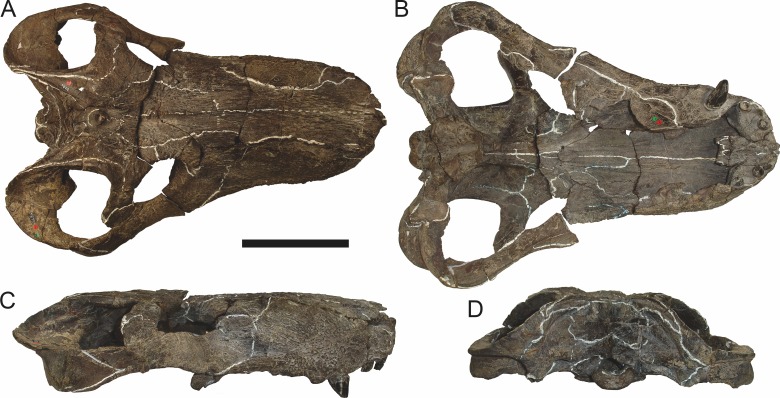
Referred specimen (UMZC T878) of Sycosaurus nowaki (Broili & Schröder, 1936) in (A) dorsal, (B) ventral, (C) right lateral, and (D) occipital views. Scale bar equals 10 cm.Holotype of Leontocephalus intactus
Kemp, 1969. Scale bar equals 10 cm.